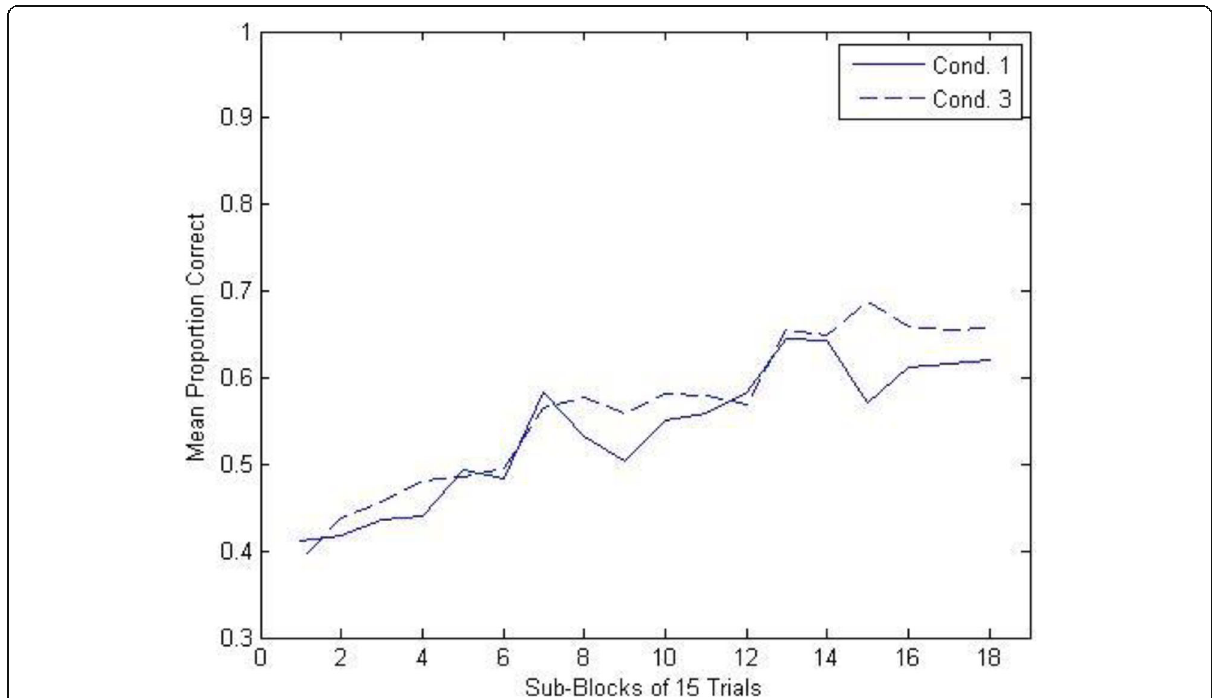
Fig. 9 Yoked experiment 1B: mean proportion of correct high-level classification responses as a function of conditions and sub-blocks during the training phase. Cond.